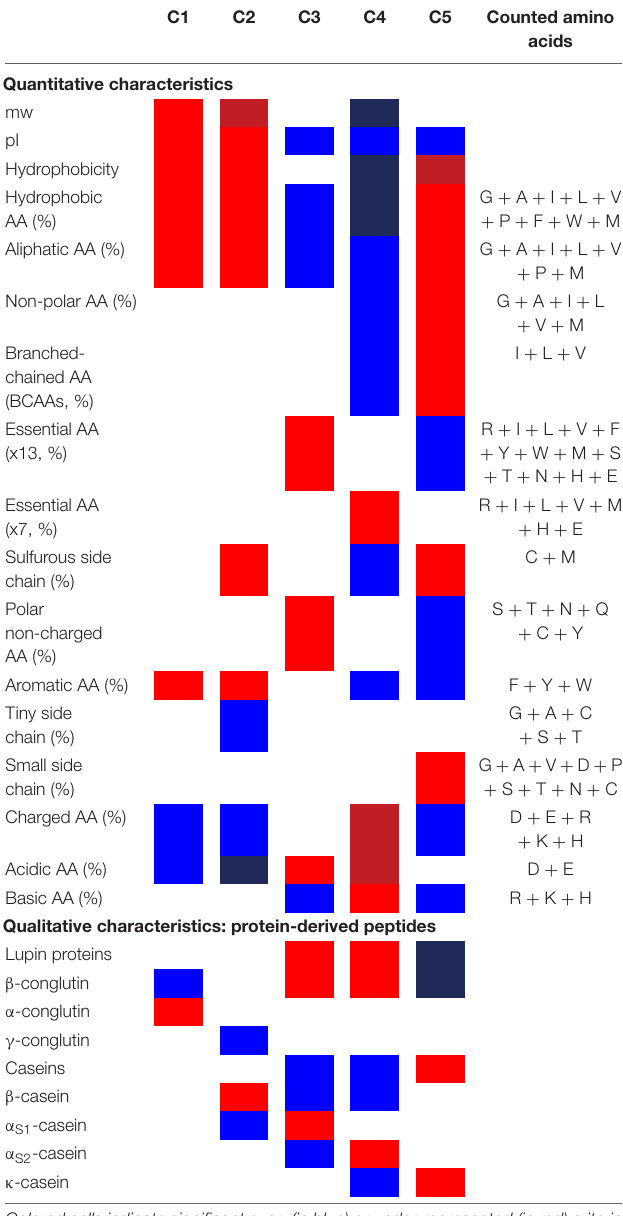
Colored cells indicate significant over- (in blue) or under-represented (in red) criteria between clusters. Dark blue = v test > 5, light blue = 2 < v test > 5, dark red = v test < -5, light red = -2 < v test >